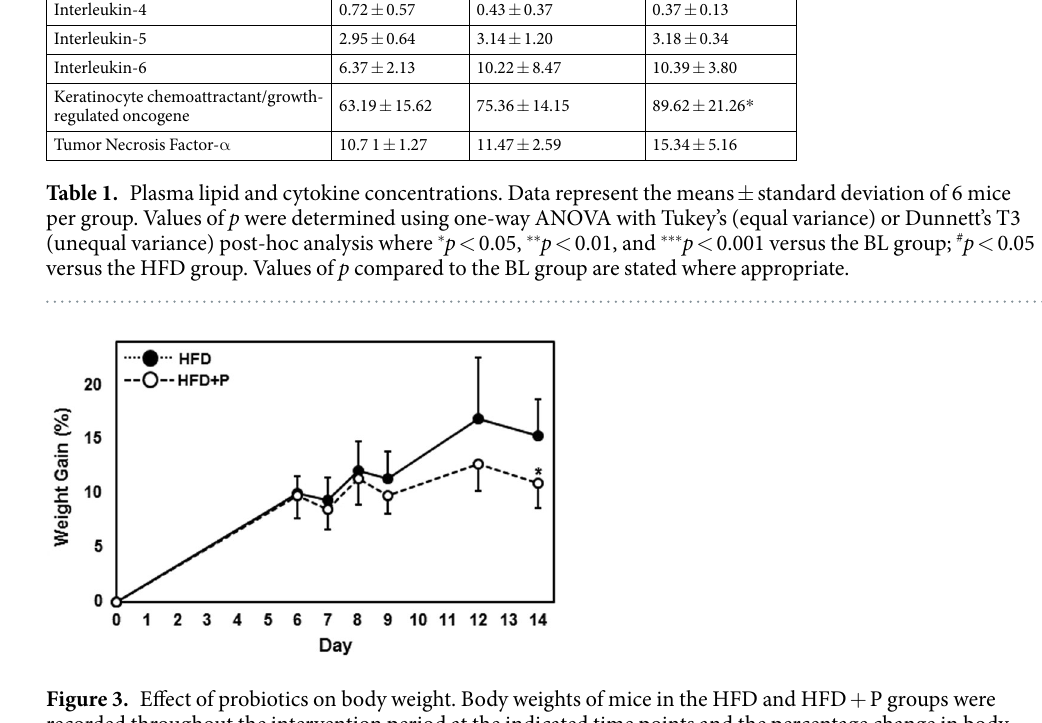
Figure 3. Effect of probiotics on body weight. Body weights of mice in the HFD and HFD + P groups were recorded throughout the intervention period at the indicated time points and the percentage change in body weight since day 0 was calculated for each mouse. Data is presented as the mean ± SD for 6 mice in each group. Statistical analysis was performed using Student’s t -test where * p <